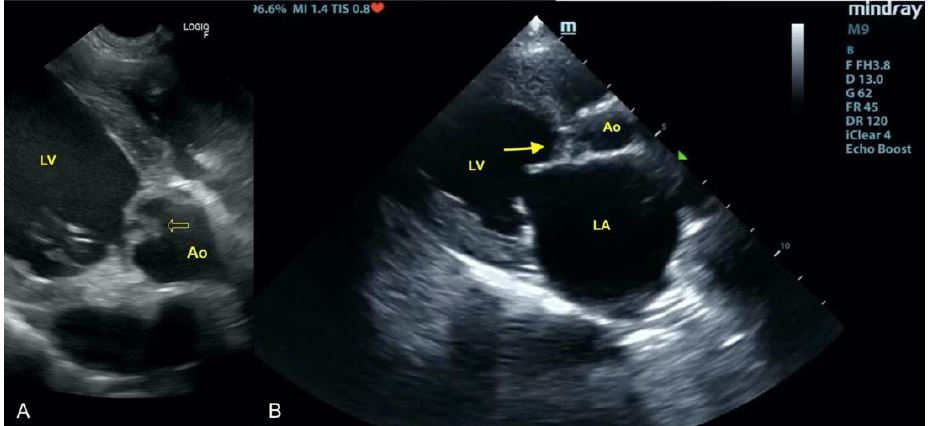
Figure 1. Vegetations and proliferative lesions on the aortic valve. Ao—aorta, LV—left ventricle LA—left atrium, yellow arrow—changed aortic leaflets. ( A ) Scan from microconvex probe obtained during focused cardiac ultrasound examination (GE Healthcare Logiq F6). ( B ) Scan from phased array probe obtained during echocardiography examination performed by a board-certified echocardiography specialist (Mindray M9).